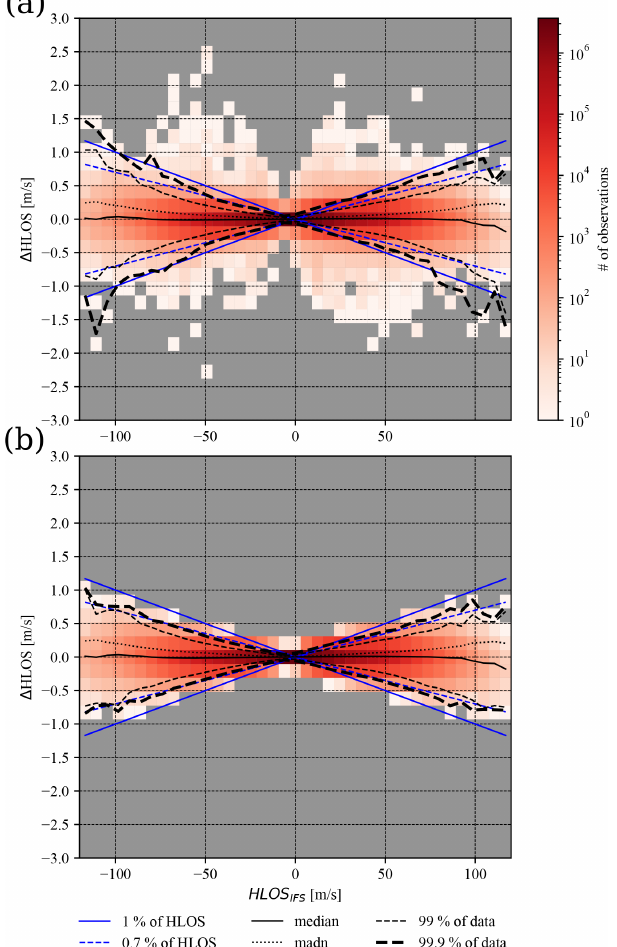
Figure 8. (a) Statistics of L2B HLOS differences (cid:49) HLOS = HLOS ARPEGE − HLOS IFS as a function of HLOS IFS wind. (b) Similar statistics but including only events associated with a temperature difference (cid:49)T = T ARPEGE − T IFS lower than 4K in absolute values. Colour shading is associated with the density of events in a particular x – y area, with grey colour showing when data are not available. Several statistics are provided for a range of HLOS winds such as (solid black) median and (dotted black) madn. The two percentiles (dashed black) indicate the range of val- ues included in 99% (or 99.9%) of the (cid:49) HLOS distribution for a particular HLOS value, highlighting outliers. Blue denotes the 1% (and 0.7%) HLOS slopes used as a reference in the discussion.